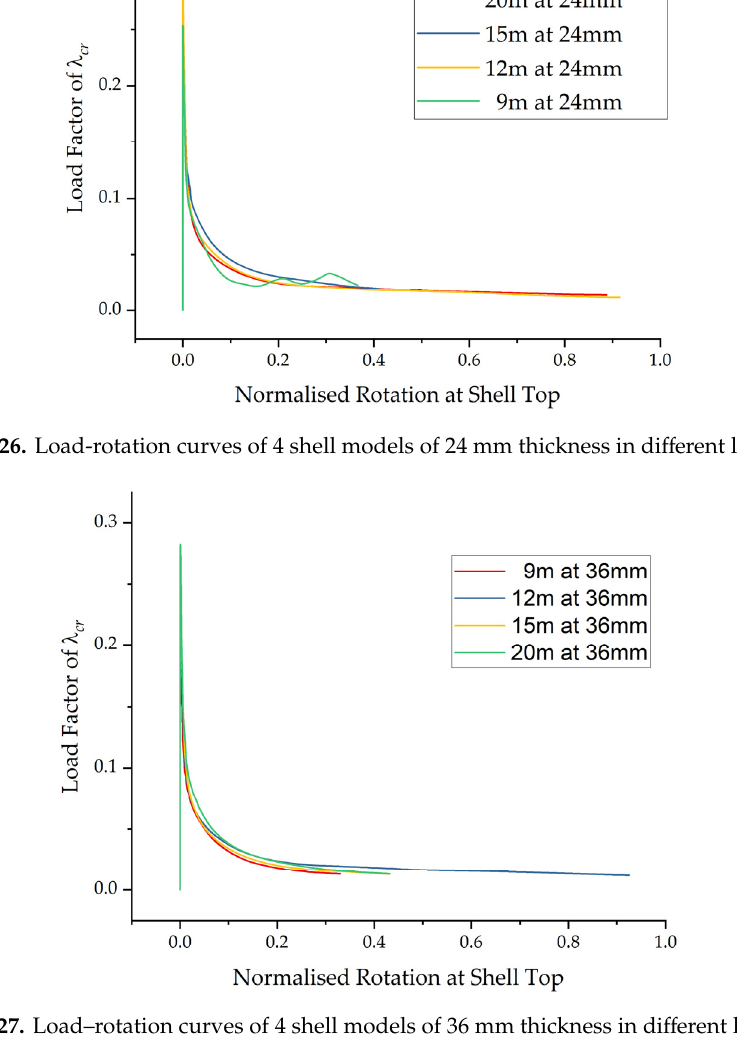
Figure 27. Load–rotation curves of 4 shell models of 36 mm thickness in different lengths.